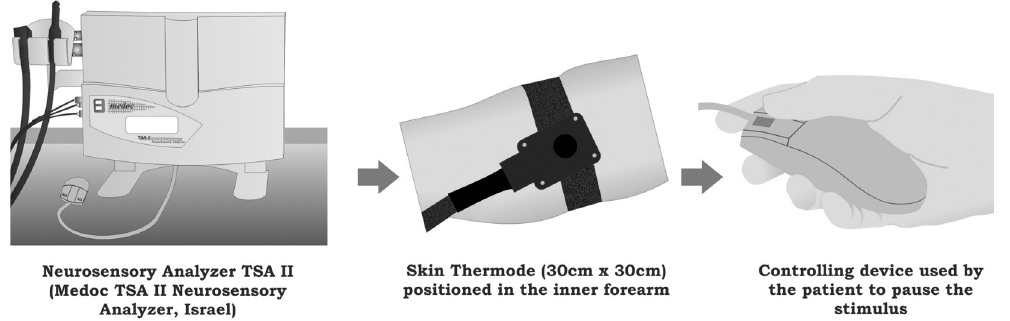
Figure 4- Scheme of the skin neurosensory analysis using the equipment TSA